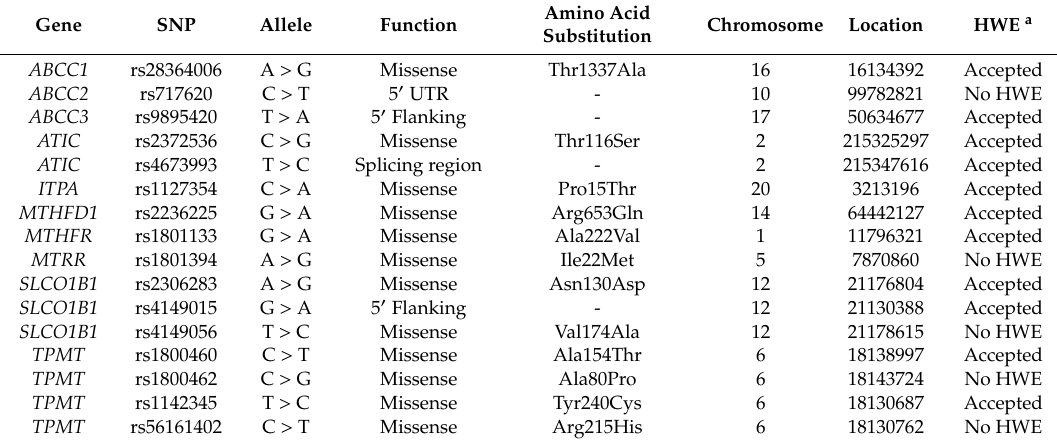
Table 1. Characterization of the polymorphisms analyzed in the present study.